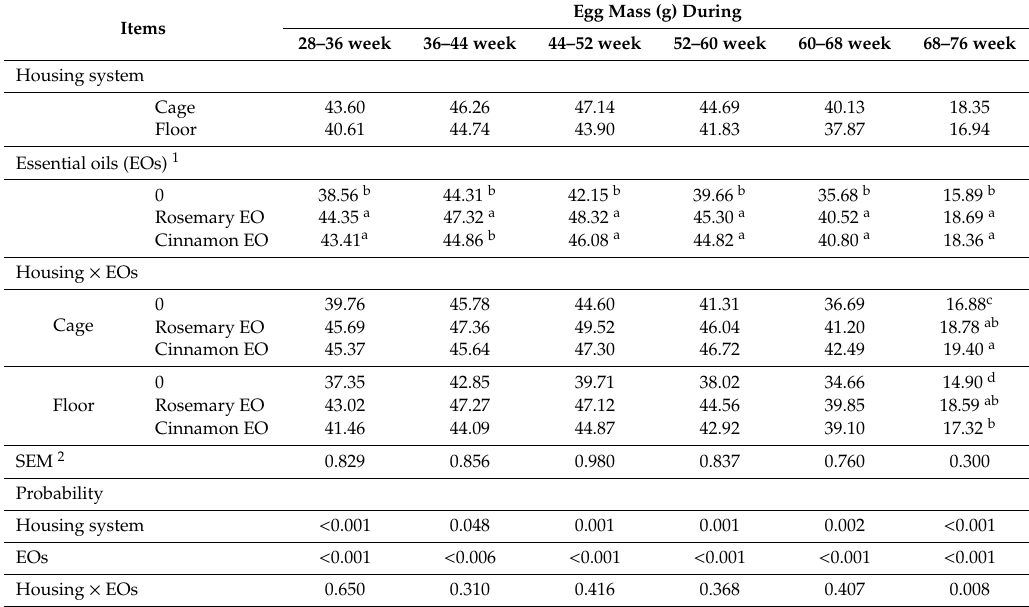
Table 4. Egg mass of laying hens as a ff ected by di ff erent housing systems, essential oils and their interaction during the